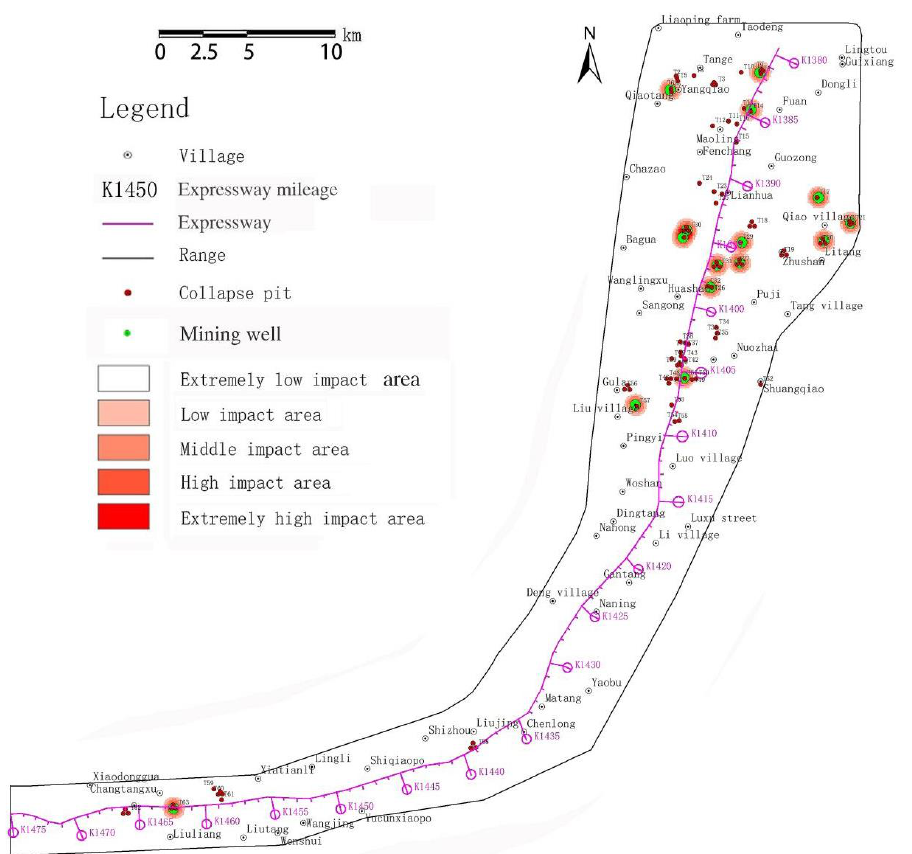
Figure 14. Zoning map of influence degree of mining well on karst collapse.